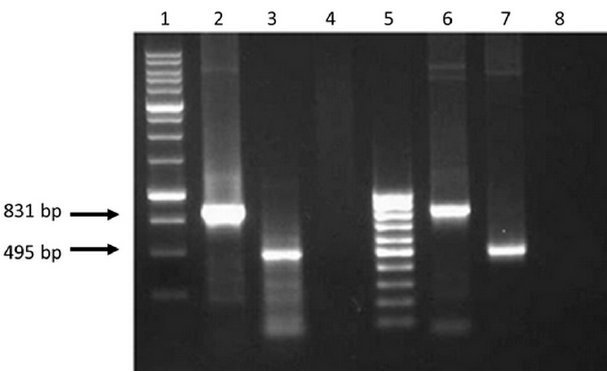
Figure 2. Electrophoregram on 1% agarose gel of PCR products: 1 - Molecular weight marker (M12, SibEnzyme); 2 and 3––PCR fragments of 831 and 495 bps obtained using cDNA as a matrix with primers (fCTL, rCTL) and (fTh, rTh), respectively; 4 and 8 – The results of PCR with primers (fCTL, rCTL) and (fTh, rTh) and total RNA isolated from 293T cells transfected with plasmids pEV.CTL and pEV.Th, respectively (without reverse transcription; control for the absence of target plasmids in isolated samples of total RNA); 5 – Molecular weight marker (M15, SibEnzyme); 6 and 7 – PCR fragments obtained using plasmids pEV.CTL and pEV.Th as a matrix, respectively (positive control).